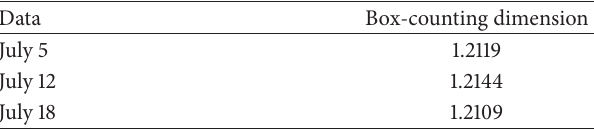
Figure 4: Actual and predicted daily load curve. Table 3: Box-counting dimension.